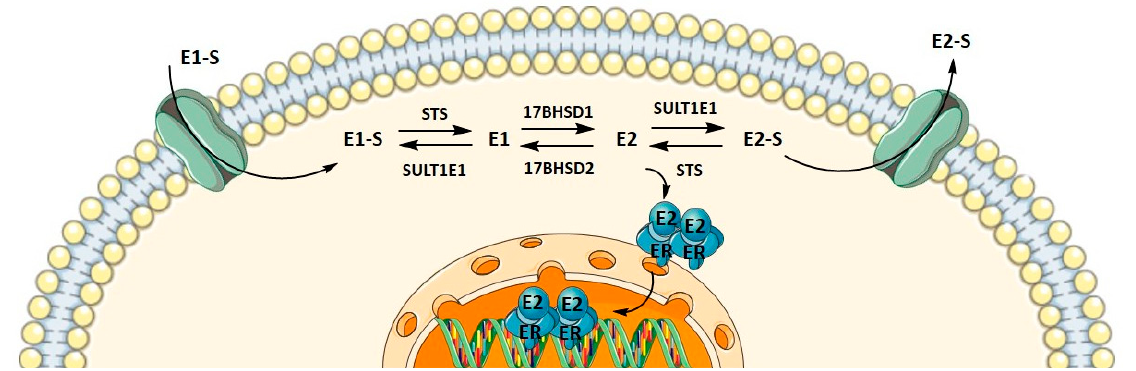
Figure 1. Uptake, intracrine action, and efflux of estrogens.